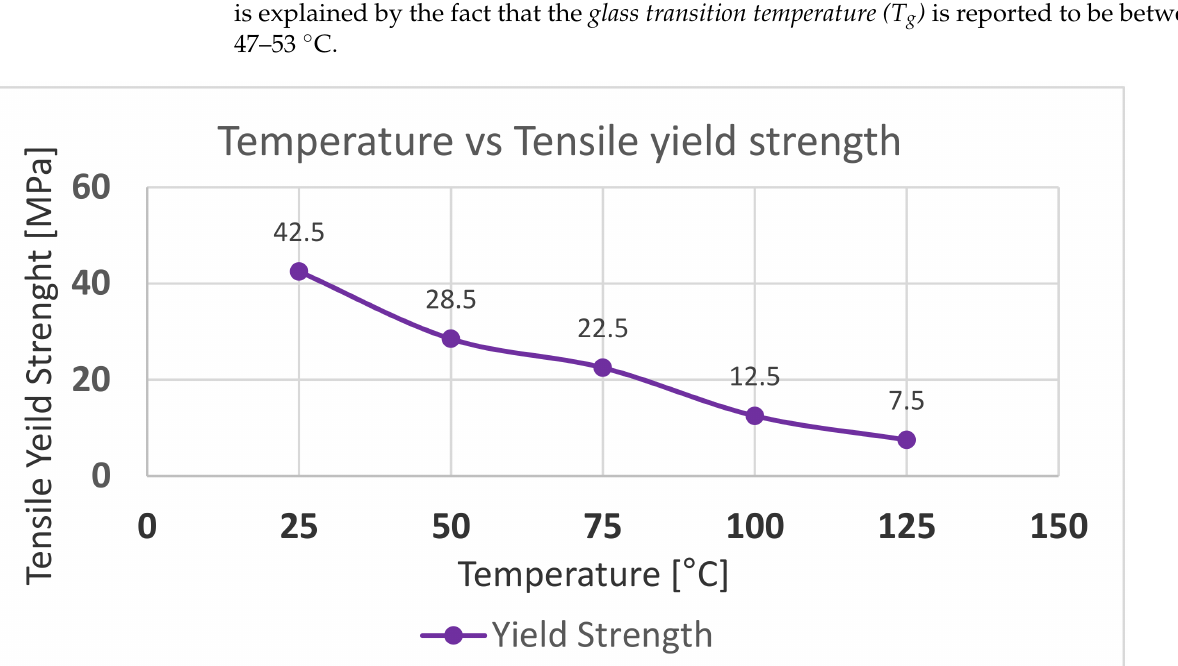
Figure 17. Tensile yield strength vs. temperature as reported in the